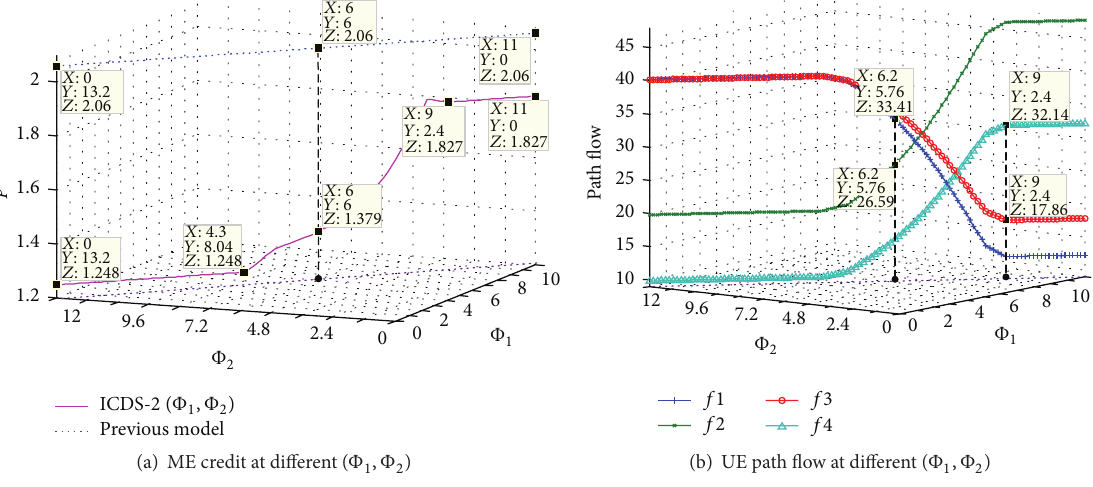
Figure 3: UE solution at different combination ( Φ 1 , Φ 2 ) under ICDS-2.